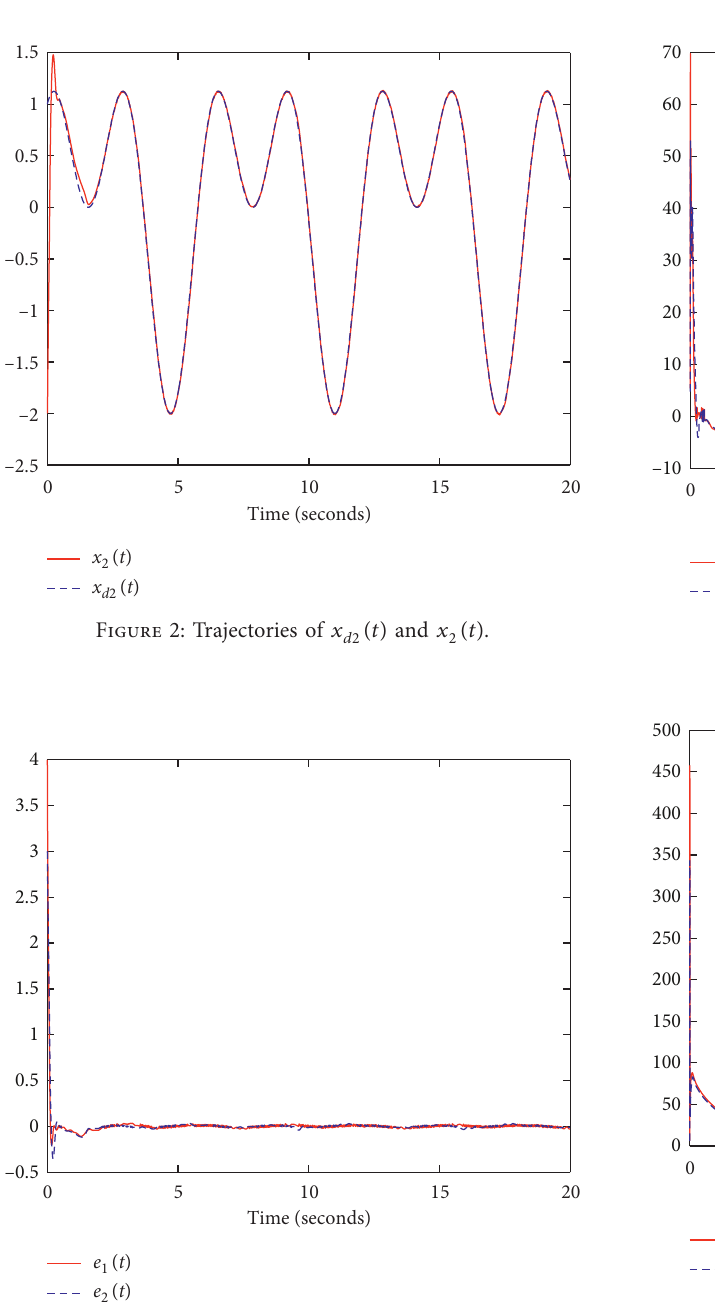
Figure 3: The tracking errors e